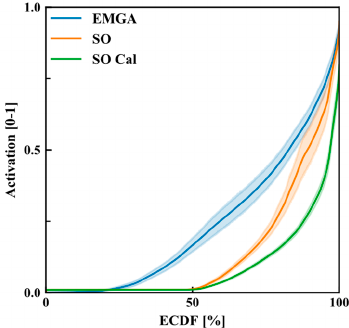
Figure 3. Muscle activations (solid line: mean value, shaded region: 95% confidence interval) predicted by EMGA (blue), SO (orange) and SOcal (green) * Teres major activation was synthesized.